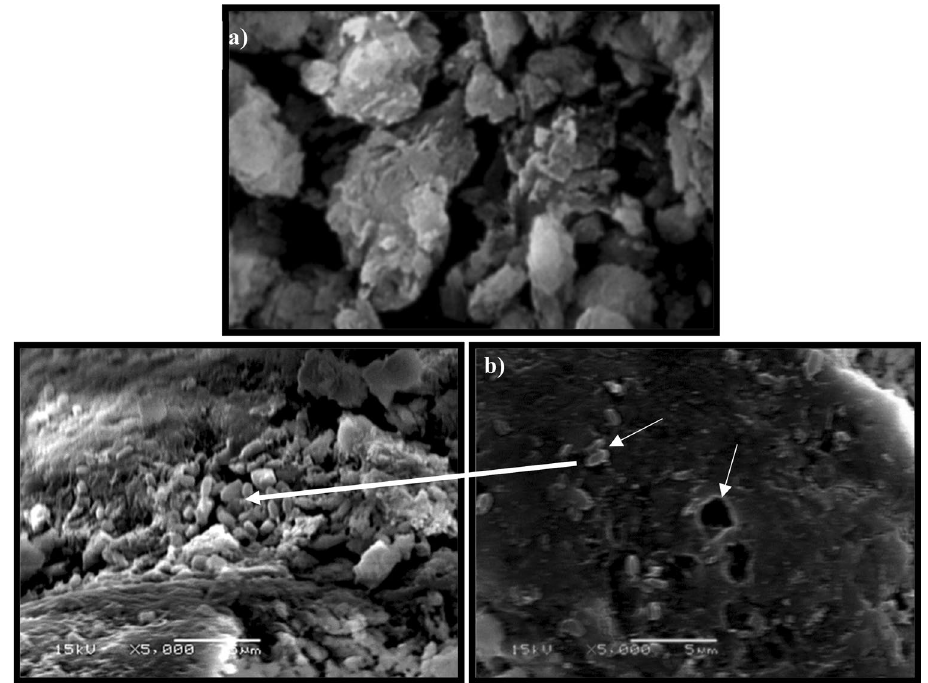
Figure 8. Scanning electron microscopy (SEM) micrograph of the animal bone powder of the ( a ) untreated (control) sample and ( b ) treated sample after fermentation showing the morphological surface of the bone at a magnification of 5000 with 15